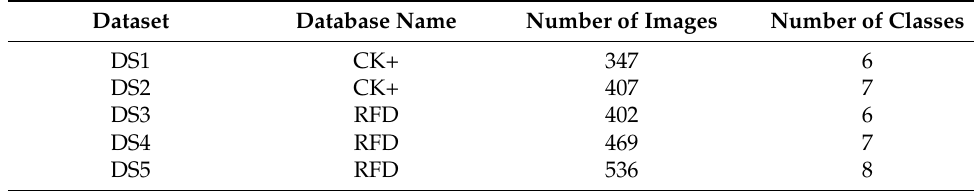
Table 2. Summary of the